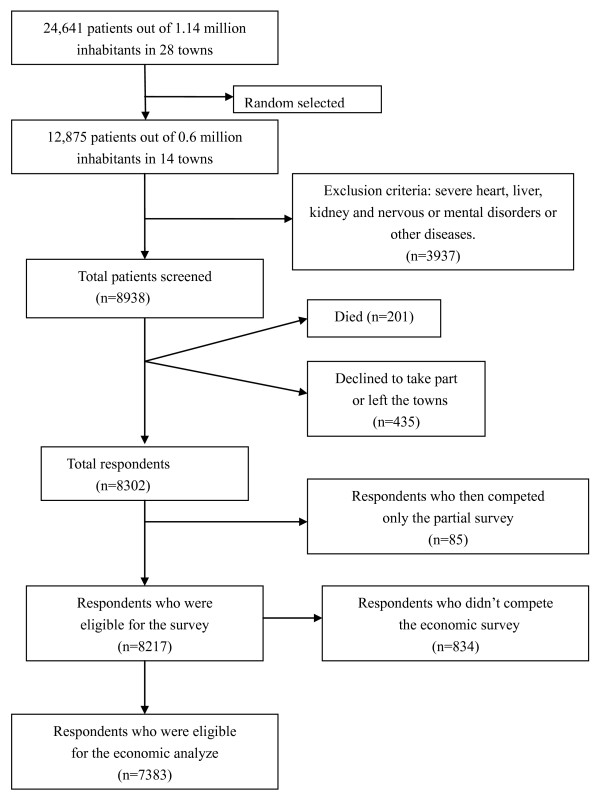
Sample construction.